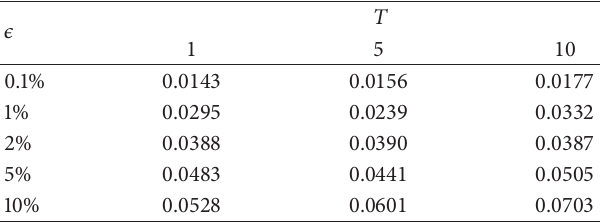
Figure 1: The effect of an increasing number of 𝑁 on the condition number of 𝐵 for the cases when 𝑡 0 ∈ {1𝑒 − 8, 1𝑒 − 9, 1𝑒 − 10} . Table 1: Example 1: the relative errors with 𝑡 0 = 1𝑒 − 10 , 𝑁 = 59 , and 𝑚 = 59 .